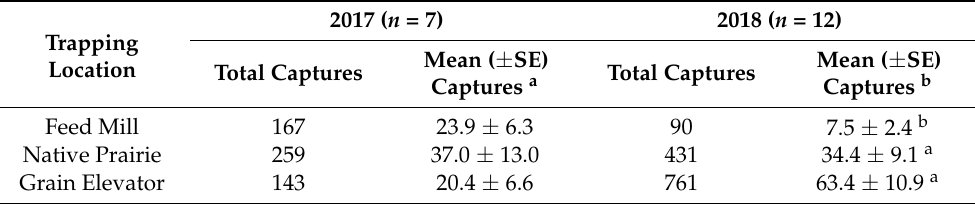
Table 5. Combined total and mean ( ± SE) Rhyzopertha dominica captured in Lindgren traps baited with one of six different attractant types, among three different ecologically different landscapes (each trapping period represented a